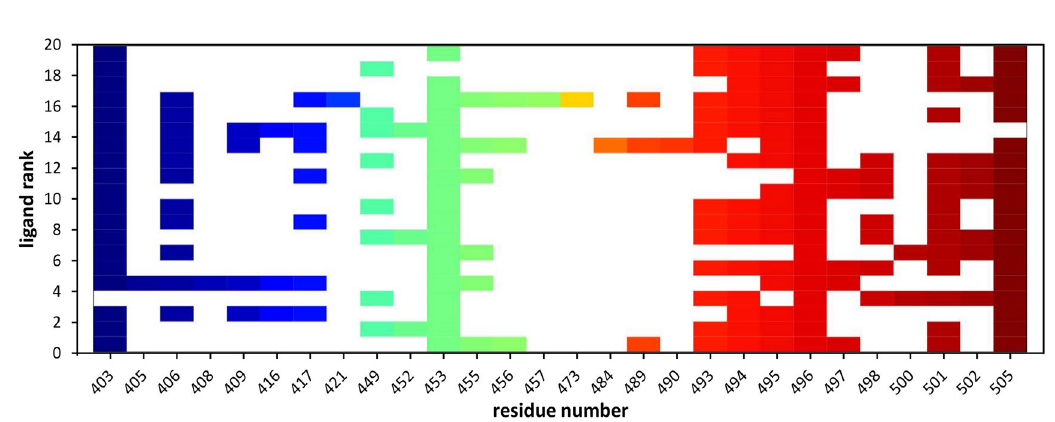
Figure 3. The interaction fingerprint matrix of docking poses into the Delta RBD site. Colored bars indicate one or more interactions between Delta residues (columns) and individual ligands (rows). Different colors indicate different